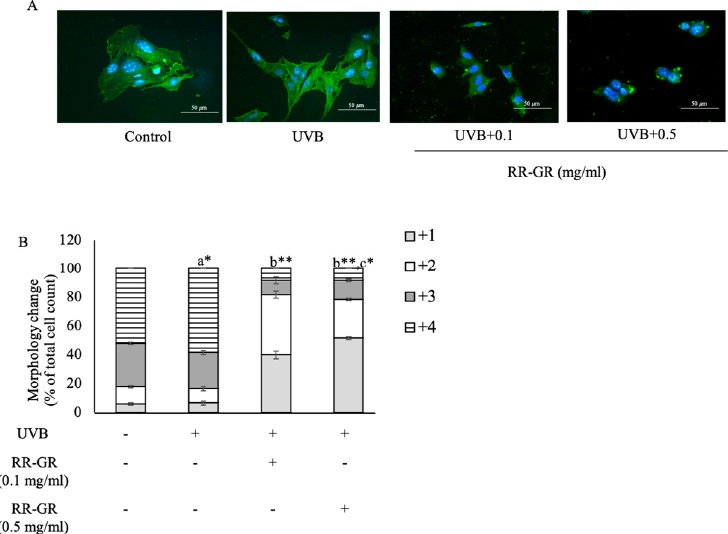
Figure 6. Morphology change-related F-actin rearrangement; the scale bar was at 50 µ m. Control was present as untreated cells. (Blue: nucleus, green: F-actin rearrangement) ( A ). The morphology was graded as +1, +2, +3, and +4 from the total of 100 cells. The results were expressed as a percent cell morphology ( B ). a represents statistical significance compared with control. b represents statistical significance between radiated and treated cells. c represents statistical significance between treated cells. *, ** Statistical significance at 𝑝 ≤ 0.05 and 𝑝 ≤ 0.001, respectively.